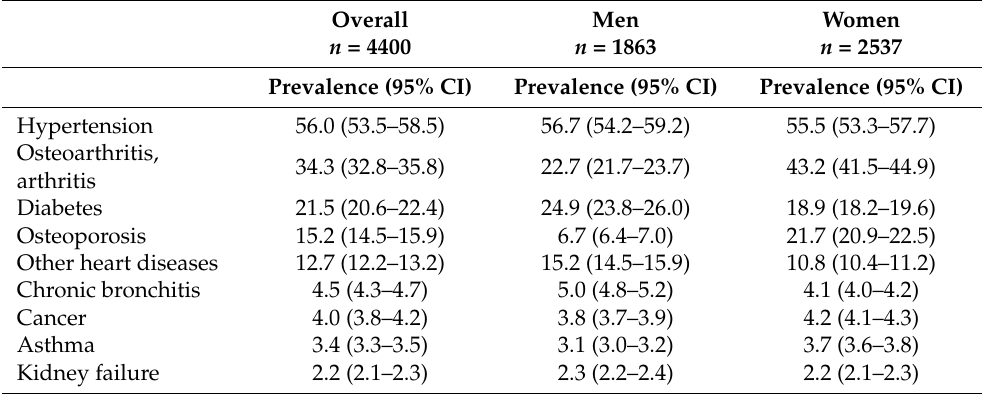
Table 2. Weighted prevalence and corresponding 95% confidence intervals (CI) of chronic diseases in the study population, reported overall and by gender.